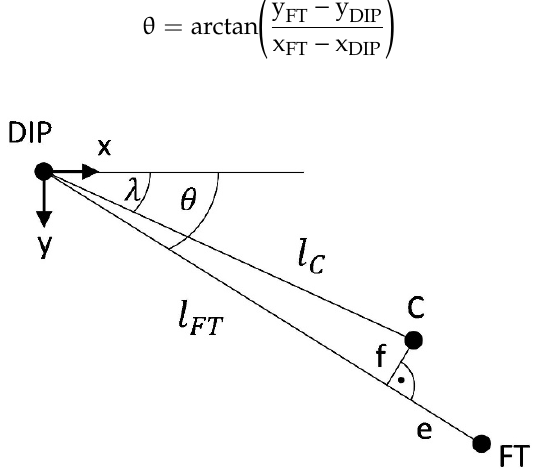
Figure 8. A scheme showing the displacement between FT (fingertip) and C. Table 1. Design parameters from kinematic calculations in Figure 5 and Figure 6.